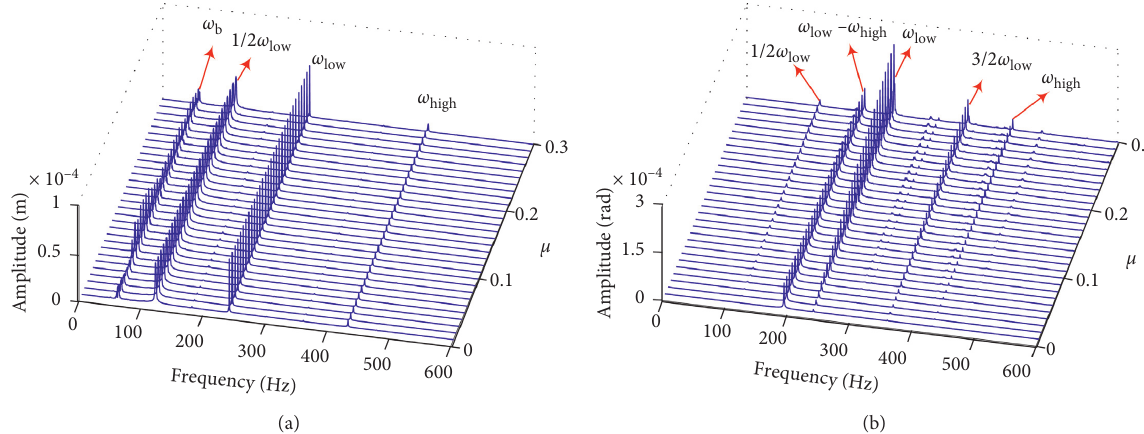
Figure 14: Spectrum cascades of the bending and torsional motions with varied rub-impact friction coefficients ( μ ∈ ( 0 , 0 . 3 ]) . (a) Bending motion and (b) torsional